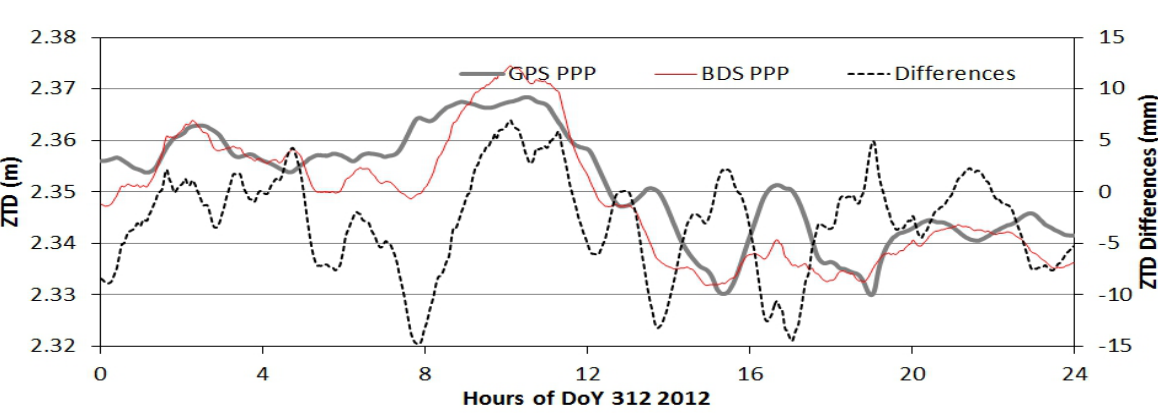
Figure 7. Comparison of ZTD derived using GPS and BDS data in PPP mode. The differences (BDSPPP-GPSPPP) are within +/ − 10 mm with a bias of − 2 to − 3 mm.